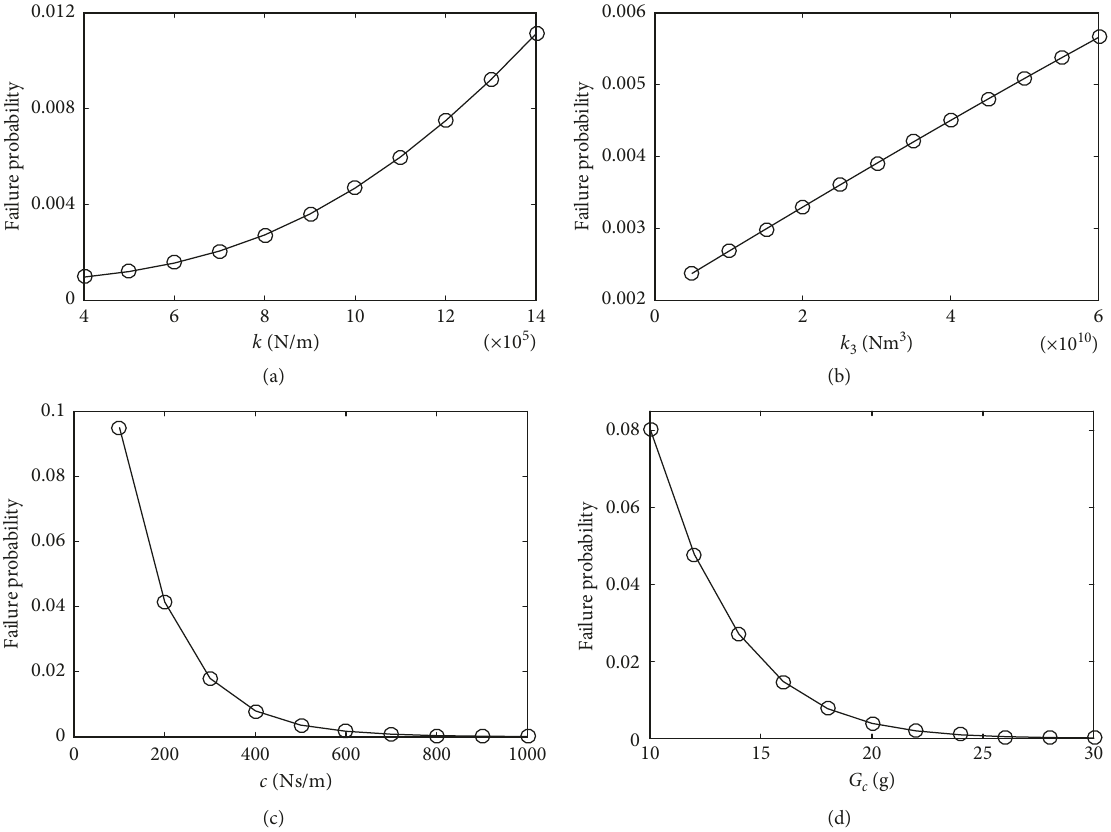
Figure 6: Effects of parameters variations on system failure